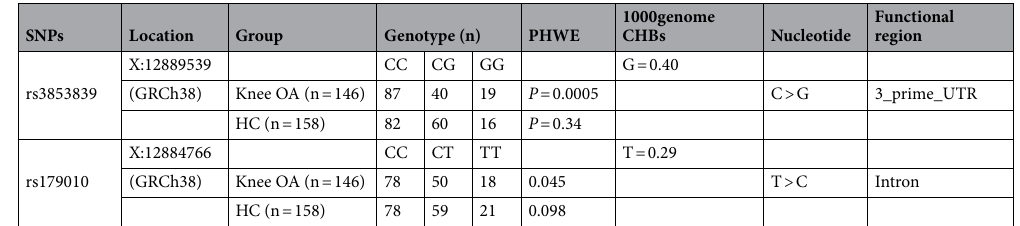
Table 3. Selected SNPs of TLR7 and PHWE in this study. Knee OA osteoarthritis patients group, HC healthy control group, PHWE P value of Hardy–Weinberg equilibrium.